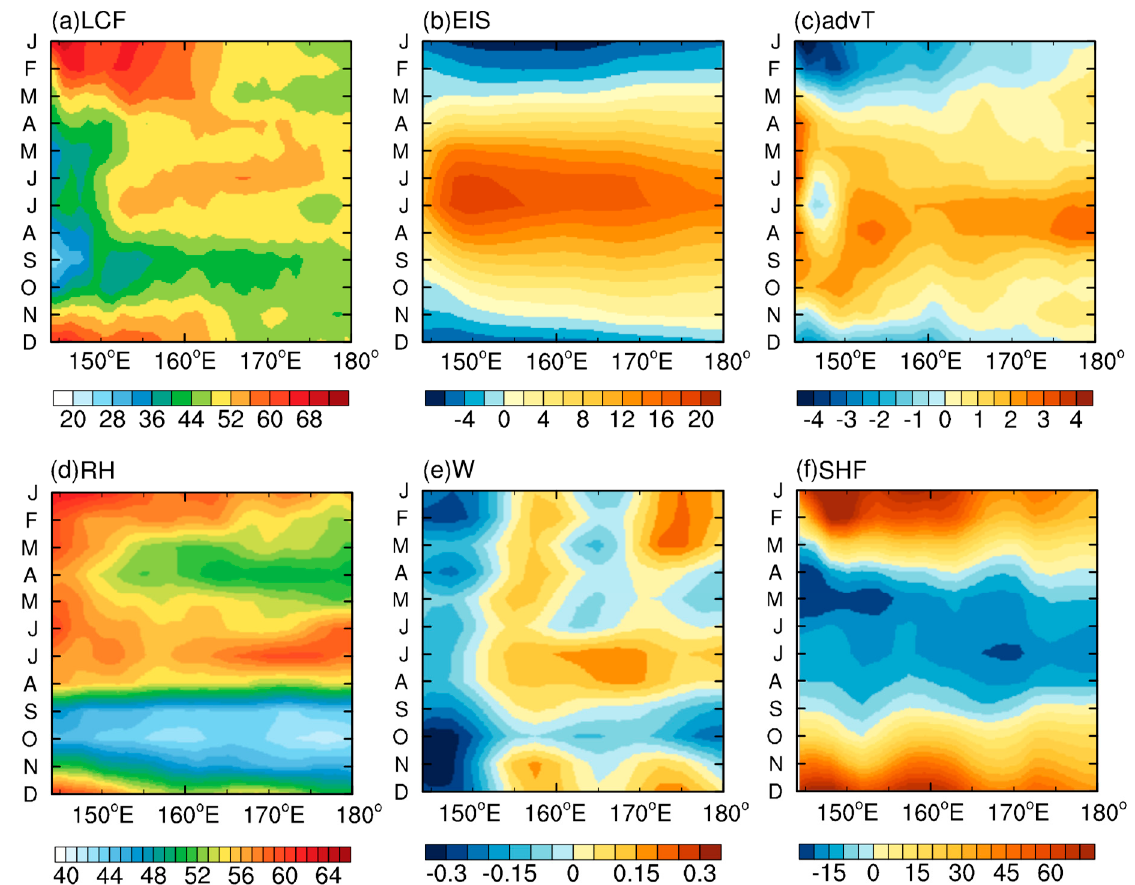
Figure 3. Time-longitude section of climatological ( a ) LCF (shading; units: %), ( b ) EIS (shading; units: K), ( c ) near-surface advT (shading; units: K/day), ( d ) 700-hPa RH (shading; units: %), ( e ) 700-hPa W (shading; units: m/s), and ( f ) SHF (shading; units: W/m 2 ) along 45° N.